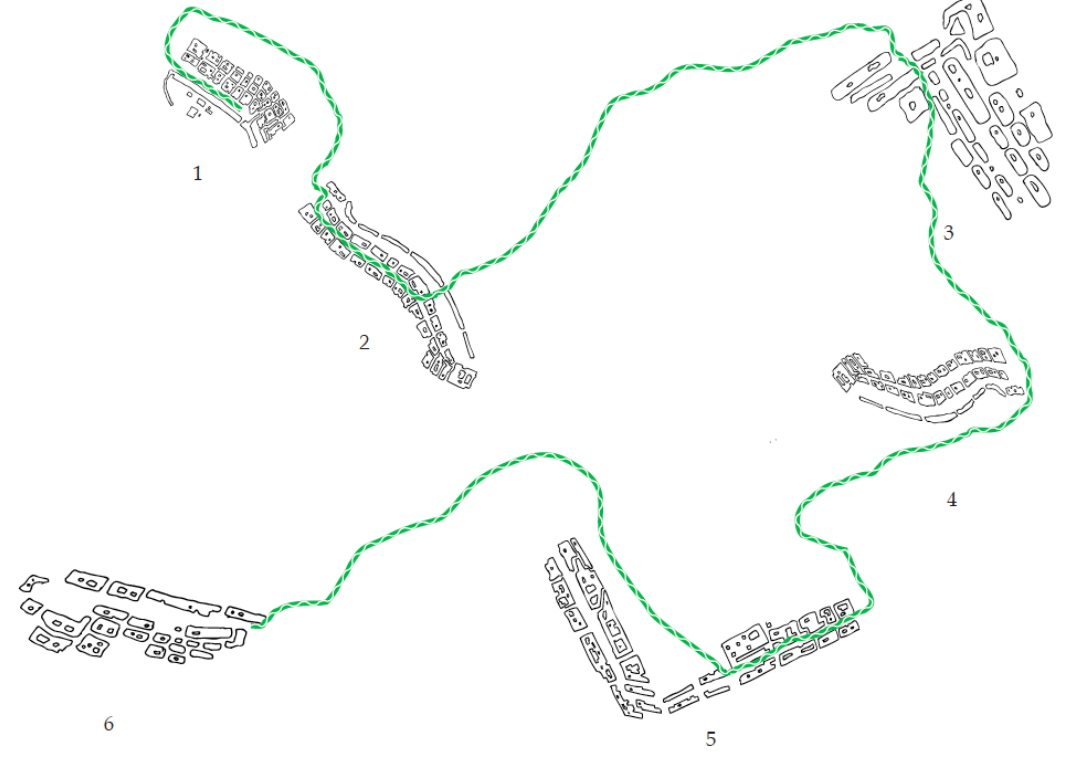
Figure 4. Ibrahim